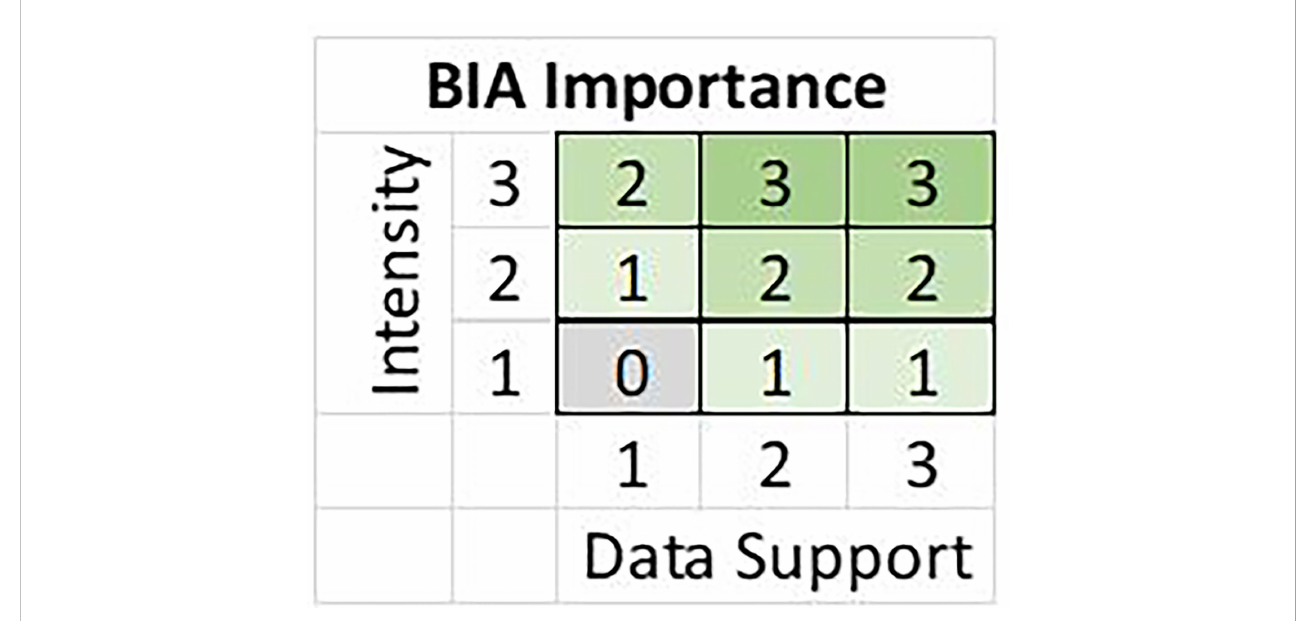
FIGURE 2 Importance matrix illustrating the relationship between Intensity and Data Support in determining the Importance score for all BIA